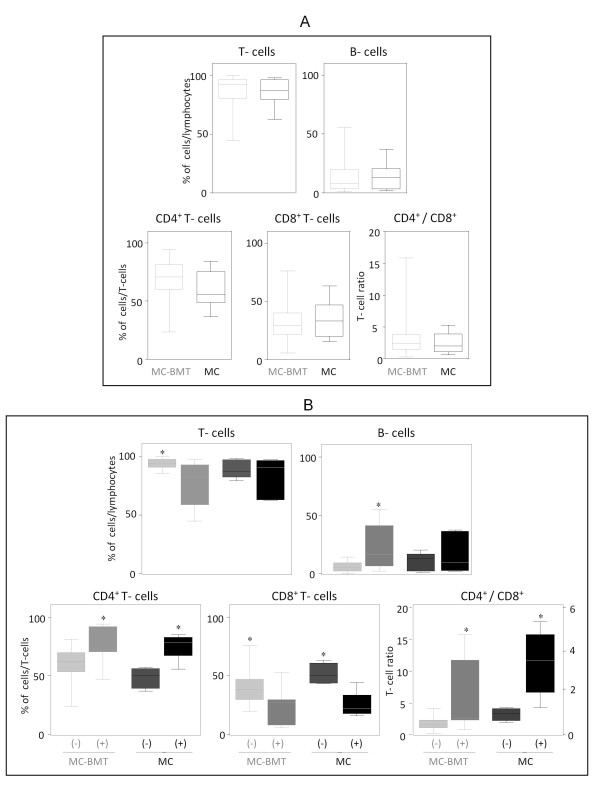
Immunophenotypic profile of tumor infiltrating lymphocyte in canine mammary carcinomas. Analysis of tumor infiltrating T-cells, B-lymphocytes and T-cell subsets from MC-BMT or MC (A), further subcategorized according to the absence (-) or presence (+) of lymph node metastasis (-) (B). Lymphocyte populations and subsets were identified by flow cytometric immunostaining as described in Material and Methods. Data were expressed as percentage of positive cells within gated lymphocytes and CD4+/CD8+ T-cell ratio. Significant differences at p < 0.05 are highlighted by asterisk.